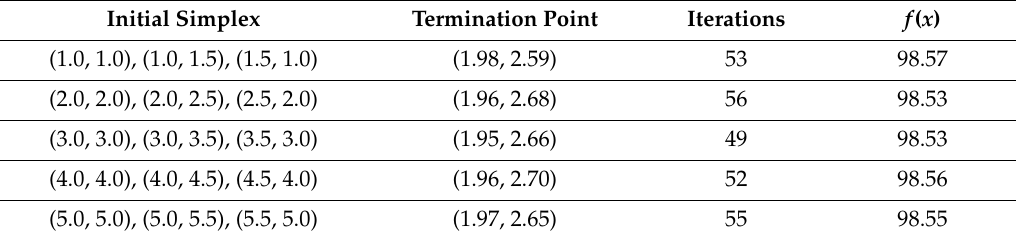
Table 3. Optimization Results Considering Unbalanced Voltage Distribution ( ± 5% Q rr Distribution).